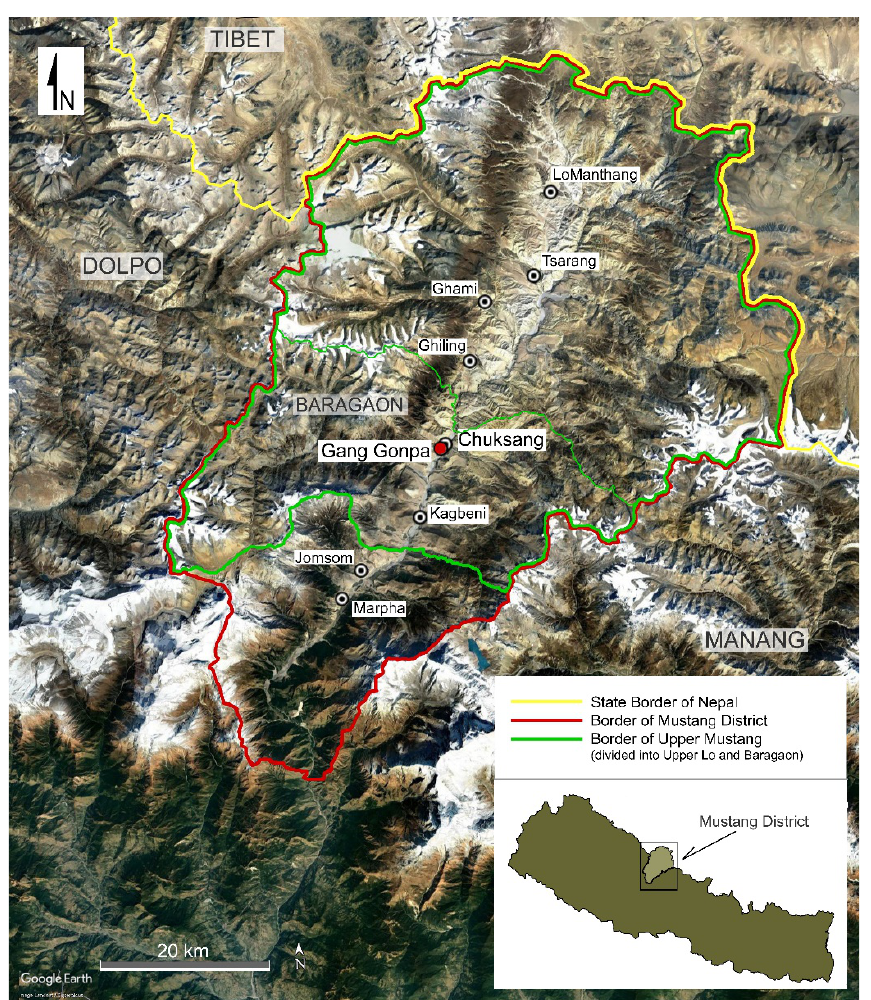
Figure 1. Location of the study area. The main settlements of the Mustang District, with the Upper Mustang restricted area (green line) including the Baragaon region. The study site, Gönpa Gang, is marked with a red dot (map prepared using Google Earth data and the scan of the map: Upper and Lower Mustang, NA518, Publisher: Himalayan Map House. Authors: Robin Boustead and Himalayan Map House).